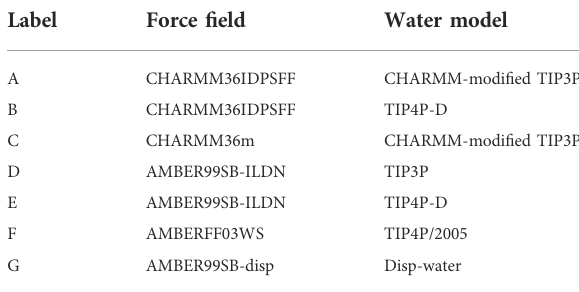
TABLE 1 Force fi elds and water models used for simulations and the labels used to denote them.